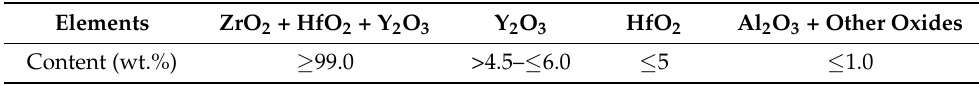
Table 1. Chemical composition of the pre-sintered zirconia block.